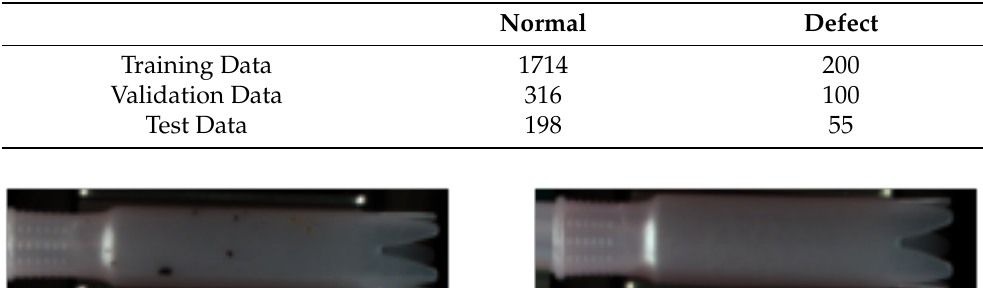
Table 4. Dataset of Proposed Model.